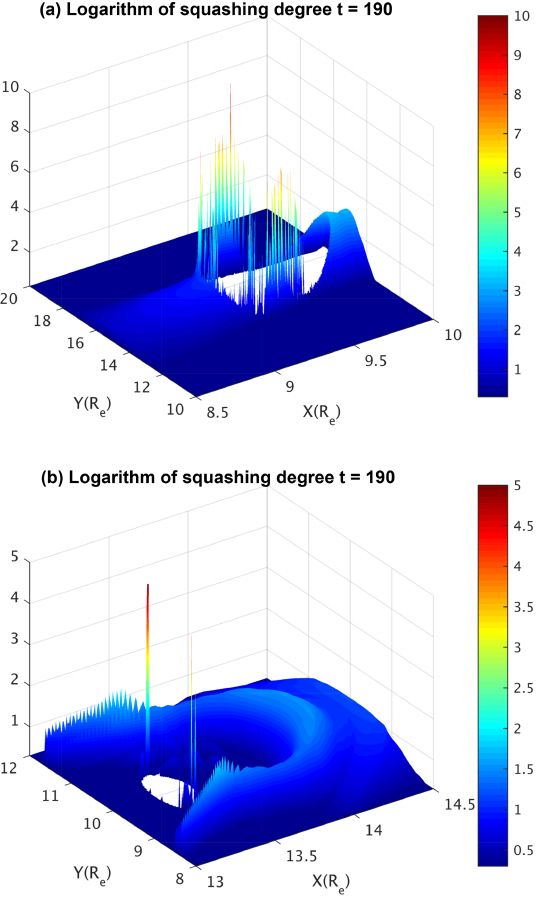
Figure 6. Iso-surfaces of the logarithm of squashing degree in the 3-D domains centered at x = 9 . 5, y = 15, z = 0 (a) and x = 13 . 4, y = 10, z = 0 (b) , respectively, at t =